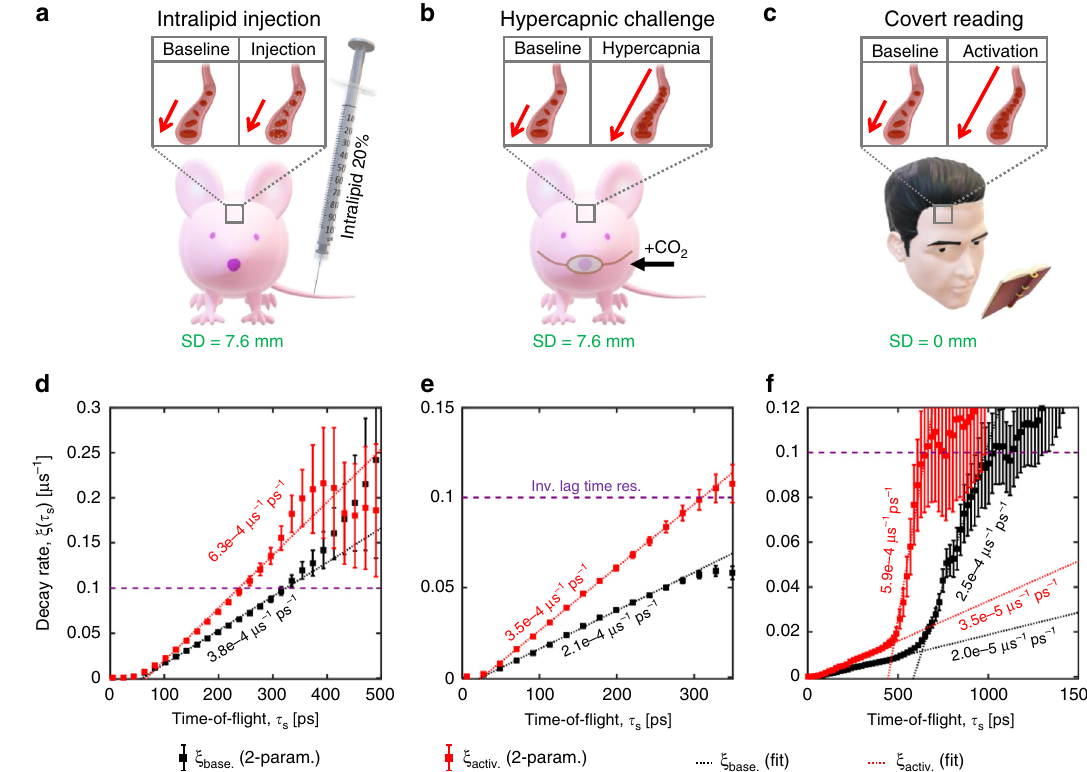
Fig. 5 Time-of- fl ight (TOF) resolved fi eld dynamics during physiological manipulations. TOF-resolved fi eld dynamics were monitored by iNIRS during three distinct physiological manipulations: tail vein injection of highly scattering Intralipid-20% ( a ) and 5% hypercapnic challenge ( b ) in mice, and a covert reading task for prefrontal cortex activation in a human subject ( c ). Decay rates versus TOF, with application of TOF-dependent averaging, reveal changes during all manipulations ( d – f ). The extracted blood fl ow indices are 8.3 × 10 − 8 cm 2 s − 1 and 1.4 × 10 − 7 cm 2 s − 1 at baseline and after Intralipid injection, respectively, in the mouse brain; 4.7 × 10 − 8 cm 2 s − 1 and 8 × 10 − 8 cm 2 s − 1 during normocapnia and hypercapnia, respectively, in the mouse brain; and 3.8 × 10 − 9 cm 2 s − 1 and 6.7 × 10 − 9 cm 2 s − 1 at baseline and during activation, respectively, for the early phase in the human forehead. In the human forehead, the slope of the late phase increases by 140% during activation ( f ). A Monte Carlo simulation, based on a two-layer model with realistic blood fl ow indices, agrees with experimental fi ndings (Supplementary Fig. 5b). Error bars represent 95% con fi dence